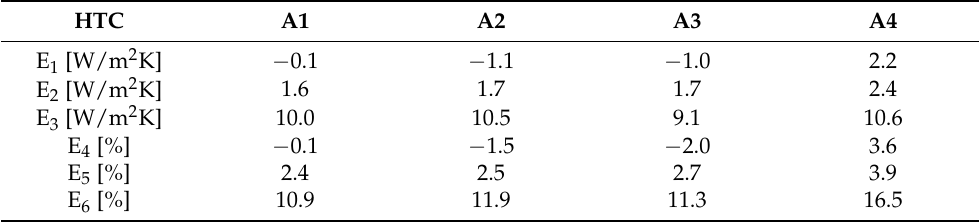
Table 14. Values of estimates E 1 –E 6 for HTC (20)–(25) with heating process p3 in planes A1–A4.